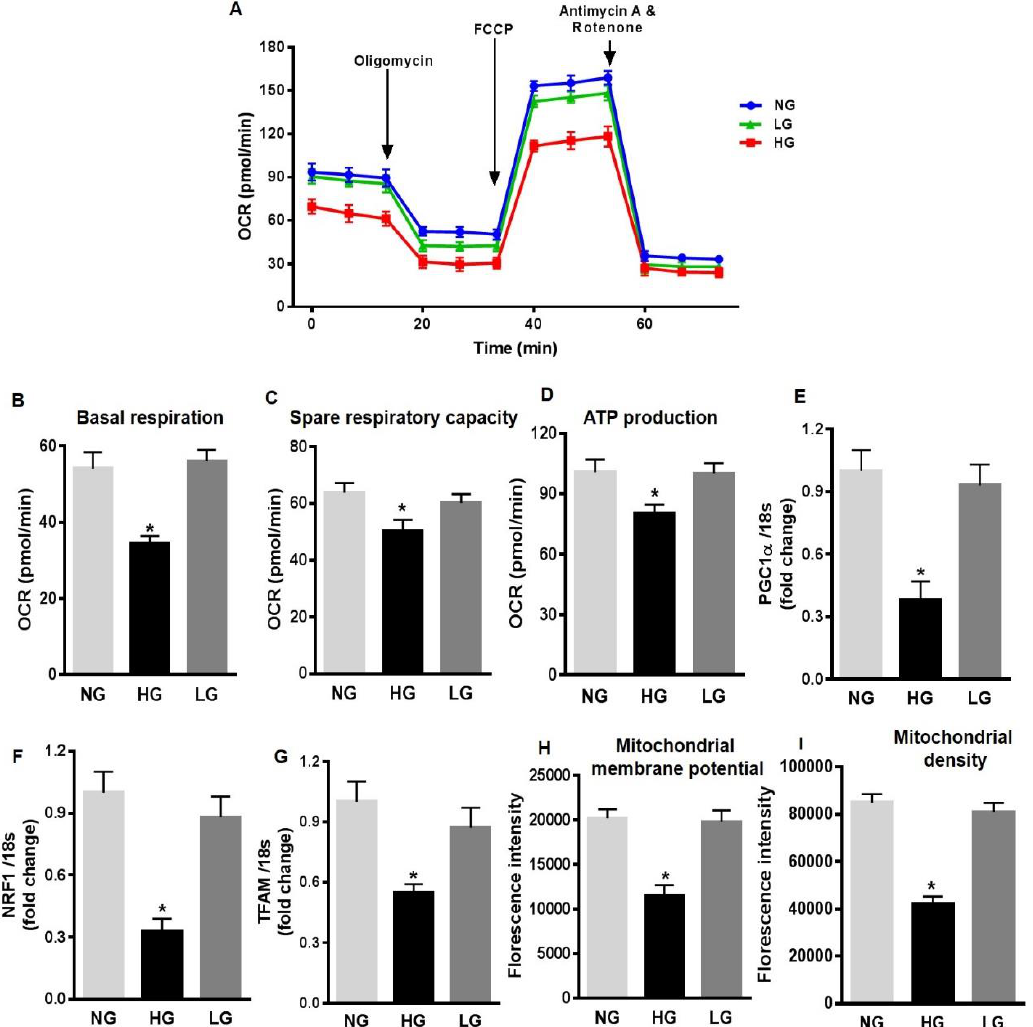
Figure 3. High glucose affects mitochondrial respiration and biogenesis in HuREC. ( A ) Oxygen consumption rate (OCR) trace was determined using a Seahorse XFp analyzer in HuREC treated for 48 h with HG (25 mM d -glucose, black bar) in comparison to cells treated with NG (5 mM d -glucose, light grey bar), or the osmotic control LG (25 mM l -glucose, dark grey bar). ( B ) Baseline, ( C ) spare respiratory capacity, and ( D ) ATP production were all decreased in HuREC treated with HG compared to NG and LG controls. ( E – F ) qPCR analysis assessing mRNA levels of genes regulating mitochondrial biogenesis: Peroxisome proliferator-activated receptor gamma coactivator 1-alpha (PGC-1 α ), nuclear-encoded respiratory complex proteins (NRF-1), and mitochondrial transcription factor A (TFAM). Bar histogram representing mRNA levels of ( E ) PGC-1 α , ( F ) NRF-1, and ( G ) TFAM genes in HuREC treated for 48 h with HG (black bar), NG (light grey bar), and LG (dark grey bar). In all cases ( D – F ) data are normalized to 18s expression and represented as fold of change. FACS analysis of ( H ) TMRE and ( I ) MitoTracker dyes of HuREC treated for 48 h with HG (black bar), NG (light grey bar), and LG (dark grey bar). Bars represent mean value ± S.E.M; * p < 0.05 vs . NG, n =